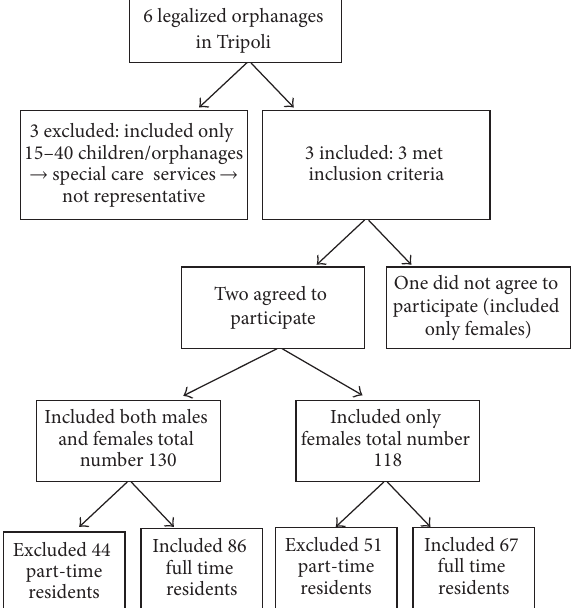
Figure 1: Sampling